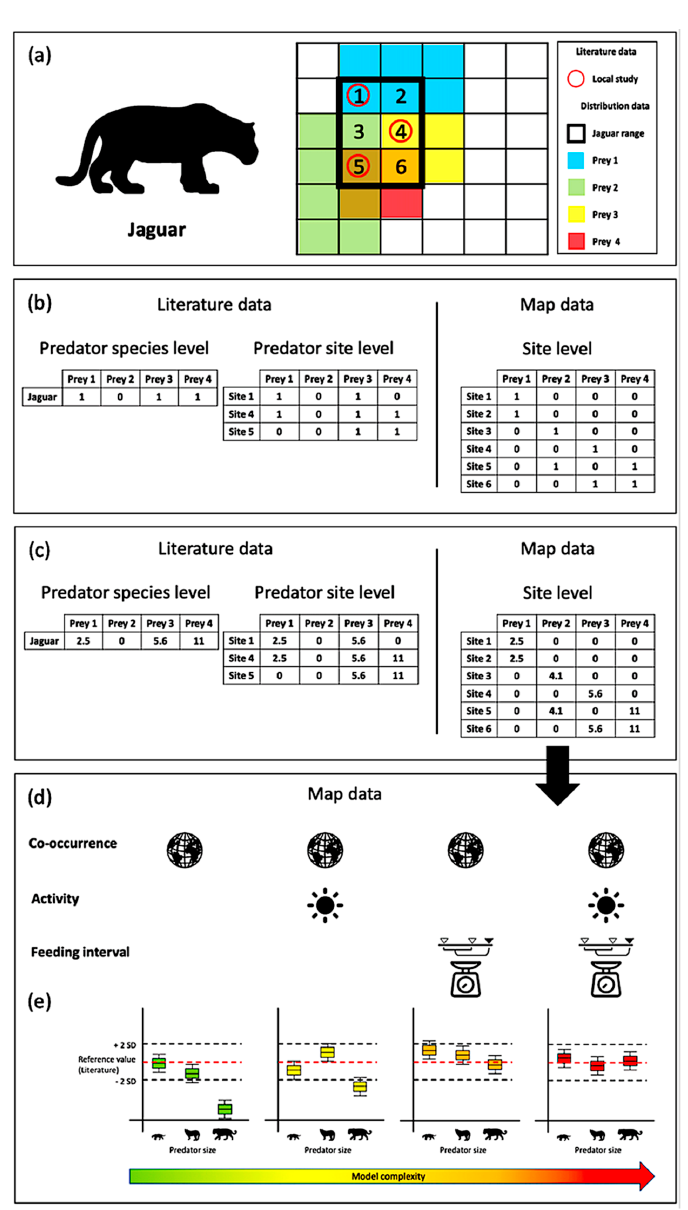
Figure 1. General approach to infer predator–prey interaction properties at the predator level combining geographic co-occurrence and Eltonian niches. ( a ) Predators that have information on predator–prey interactions, as well as range maps were selected; ( b ) from the literature and distribution data; three datasets were obtained for each predator, depicted as presence-absence matrices. The first two datasets, species level (considering the complete predator’s distribution and its reported prey) and locality level (considering only localities with literature data), were obtained from the literature and used later as reference values for interaction properties. The third dataset, the cell level, was obtained from range maps and their overlap. ( c ) The presence values (1s) are replaced by the body size of the mammal species in the three datasets. ( d ) Different trait combinations (geography: co-occurrence, life-history: activity, and morphology: feeding interval) were used to derive models of different complexities that define the potential set of prey species belonging to the Eltonian niche of the predator. ( e ) These models were used to derive descriptors of interaction properties for the predator based on the cell-level dataset, which were then contrasted against the reference values from the species- and locality-level datasets.